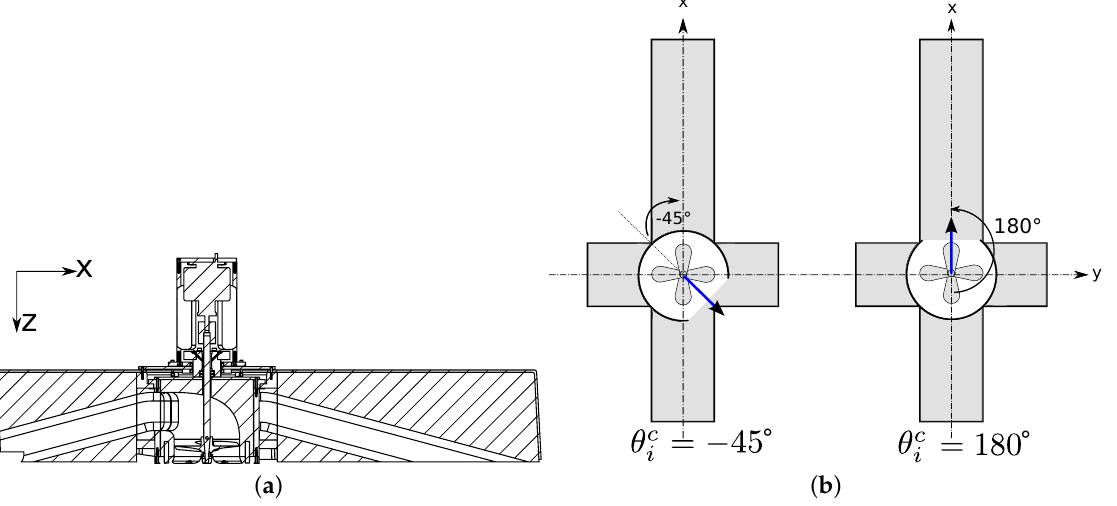
Figure 4. 360-Degrees-Steerable four-channel stern thruster: ( a ) longitudinal cross section at its symmetry plane, and ( b ) abstract top view of its bottom section for θ c from